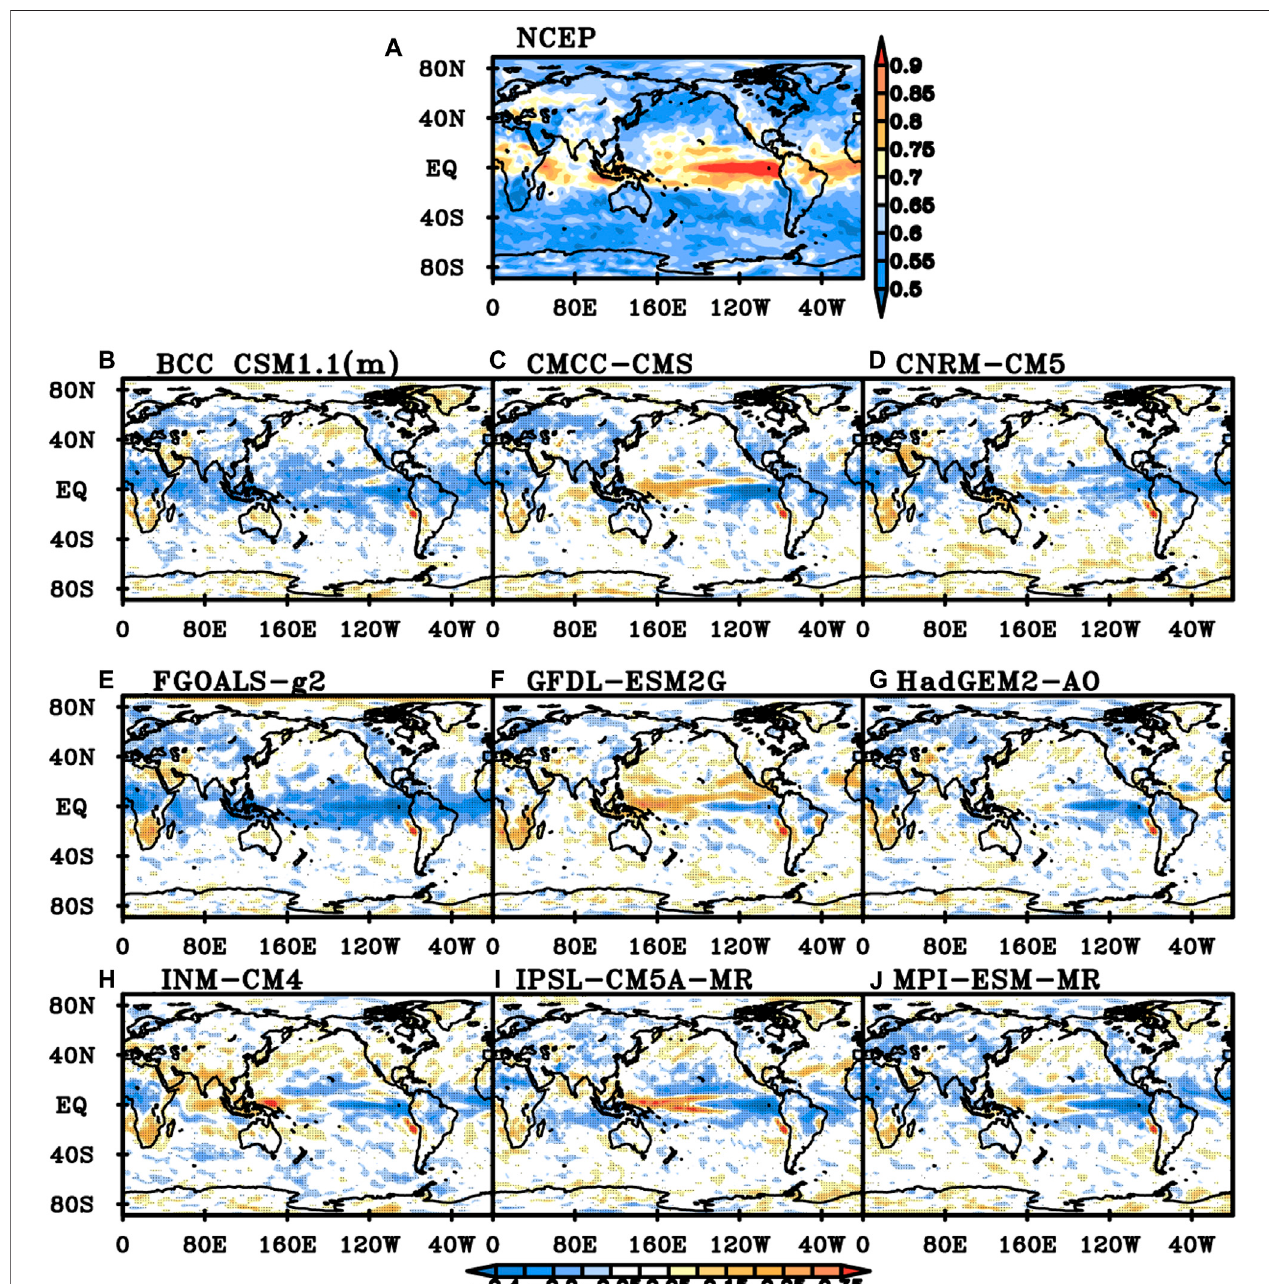
FIGURE 8 | The same as Figure 7 , but for